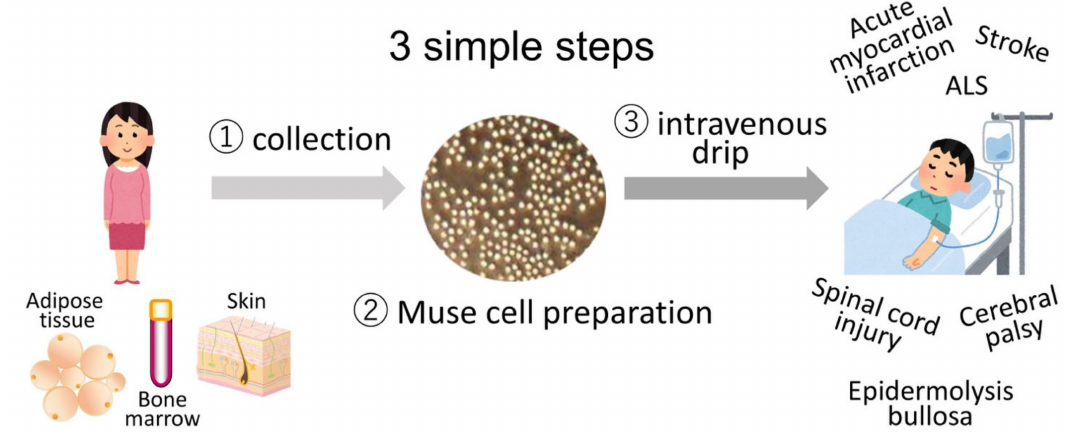
Figure 5. Strategy for Muse cell clinical trials consists of 3 simple steps. Muse cells, collectable from donor sources such as the bone marrow, adipose tissue, and skin, are expanded to produce Muse cell preparations and directly delivered to patients with acute myocardial infarction, stroke, epidermolysis bullosa, spinal cord injury, cerebral palsy, and ALS by intravenous drip without HLA-matching and immunosuppressant